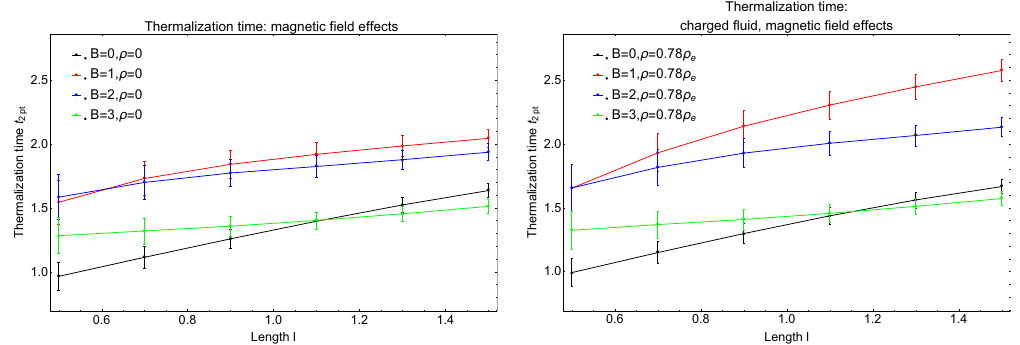
Figure 20 . Thermalization times as a function of the length. Shown here are 2-point function thermalization times t 2 pt: in a thermalizing (cid:13)uid. Left: uncharged (cid:13)uid, (cid:26) = 0, B = 0 ; 1 ; 2 ; 3. Right: charged (cid:13)uid, (cid:26) = 0 : 78 (cid:26) e , B = 0 ; 1 ; 2 ; 3. Data points have been joined by straight lines to guide the